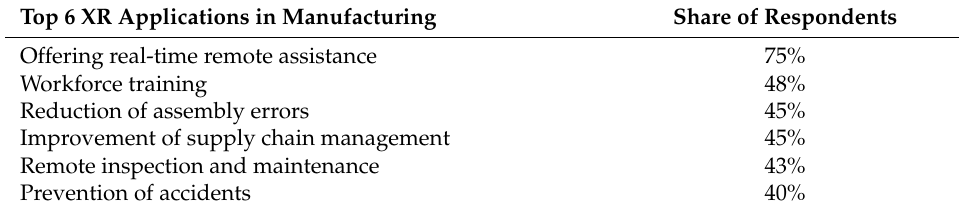
Table 5. Top 6 XR Applications in Manufacturing, source: [4].